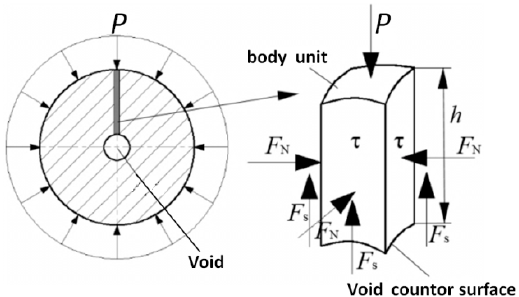
Figure 3. The mechanical model of void closure based on the FPM.